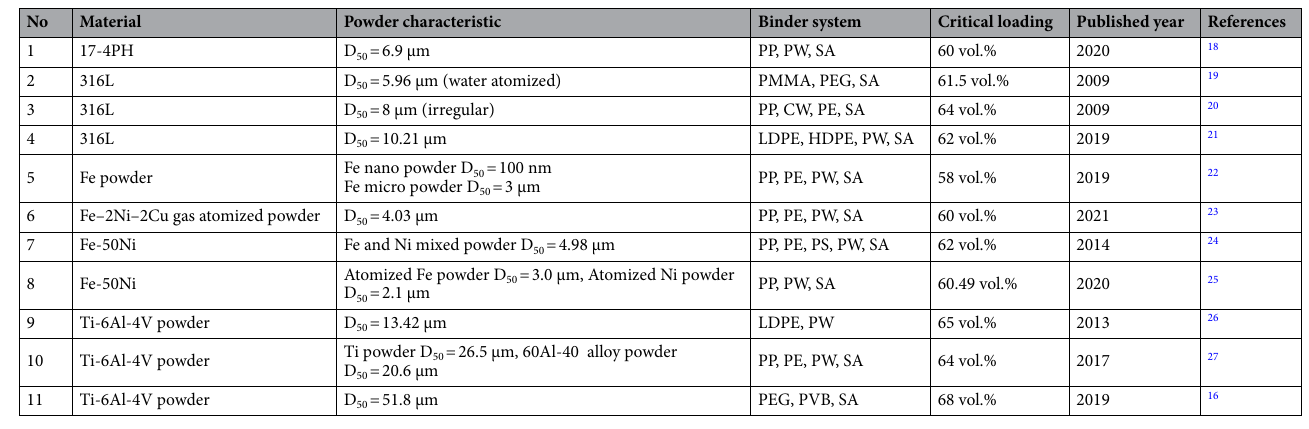
Table 1. Literature search on critical solid loading for metal injection molding.